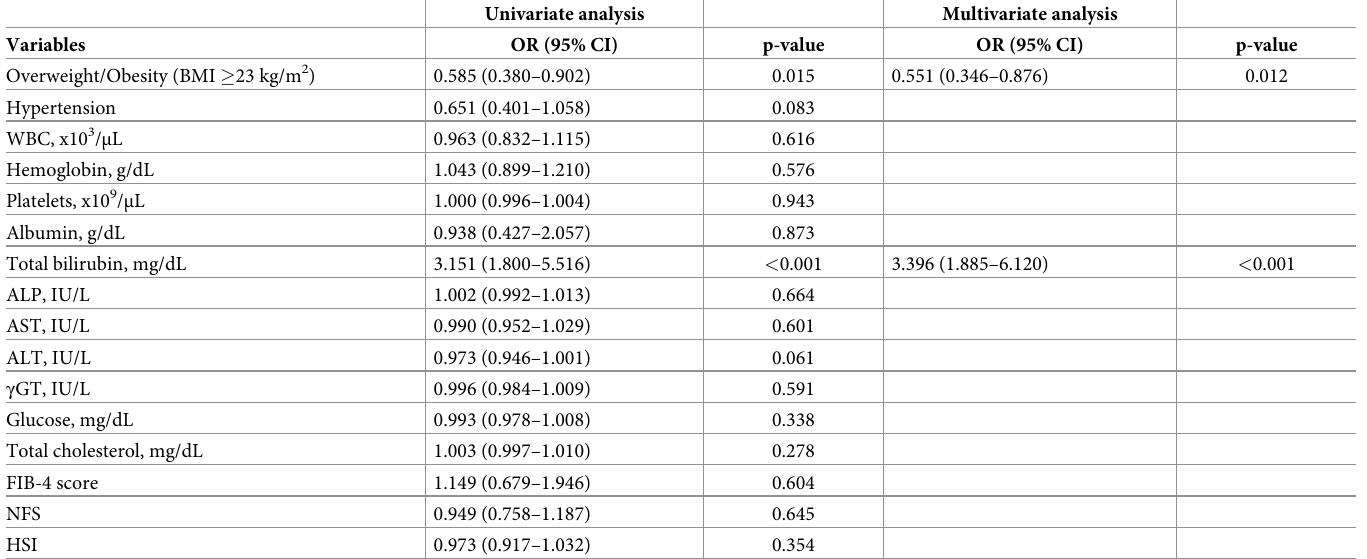
Table 2. Variables associated with elevated AFP > 7